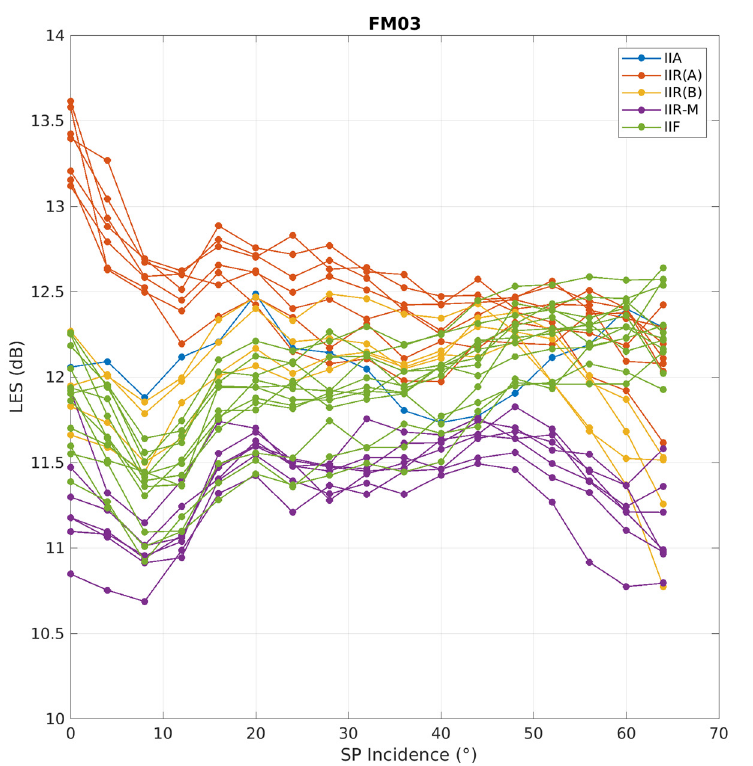
Figure A4. Dependence of LES on incidence angle, at U10 ~7 m/s, from CyGNSS FM03, segmented by SVN and coloured by GPS block.